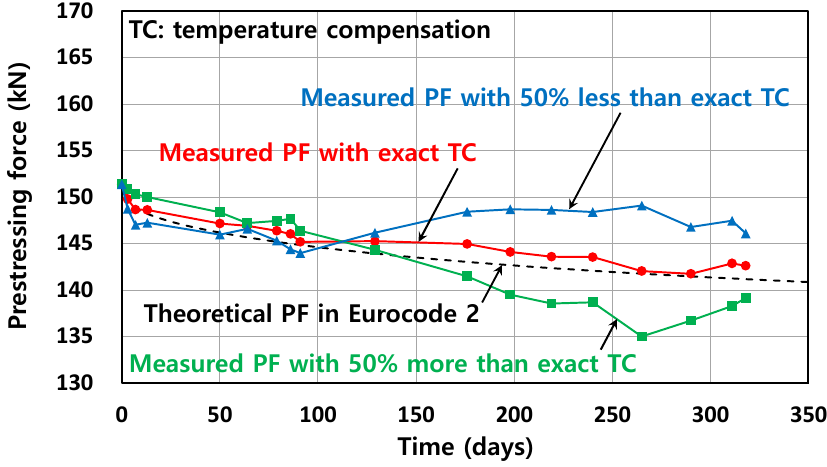
Figure 12. Comparison of PFs at mid-span for various TC.